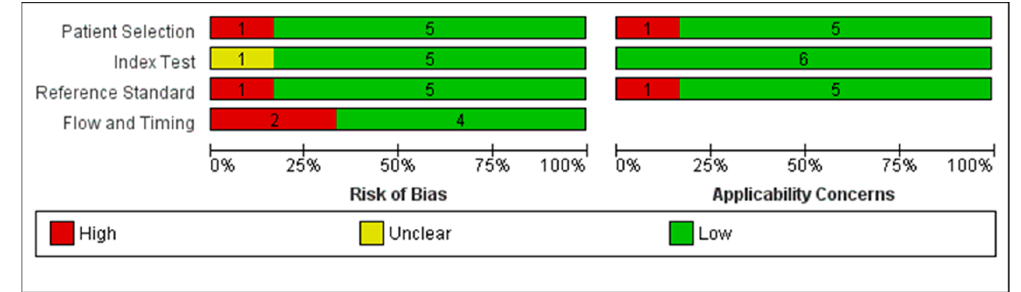
Figure 2. Risk of bias and applicability concerns: review authors’ judgements about each domain presented as a percentage across the included studies.